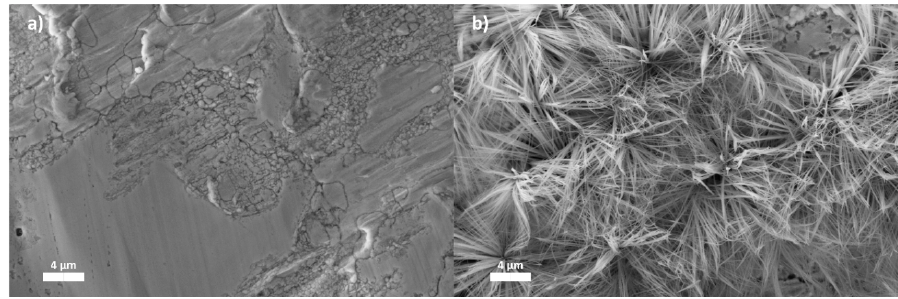
Figure 1. SEM images of rolled hot-dip galvanized (HDG) surface ( a ) and scCO 2 -treated surface ( b ).